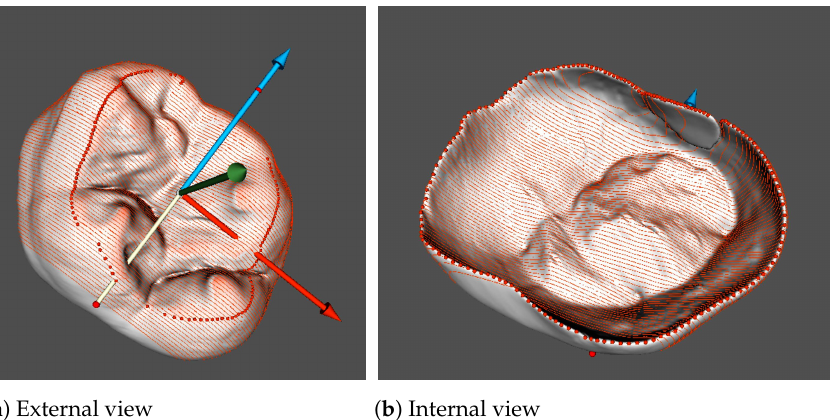
Figure 4. Odontotomy: 80-section mode; upper right second molar, S2; external view ( a ) and internal view ( b